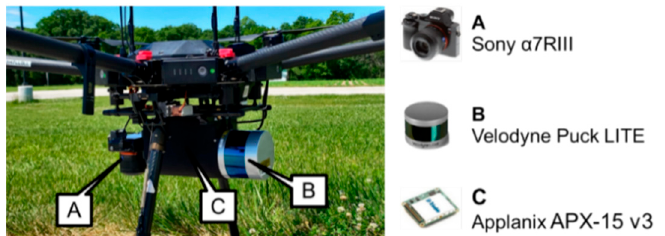
Figure 1. Flowchart of the proposed interior orientation parameters (IOP) refinement strategy.